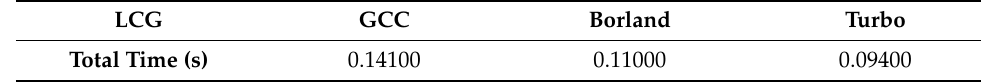
Figure 8. Total time for PRNG-based nodes comparison with cryptography. Table 3. LCG-based mobile workstation to IoT device 1 authentication time.